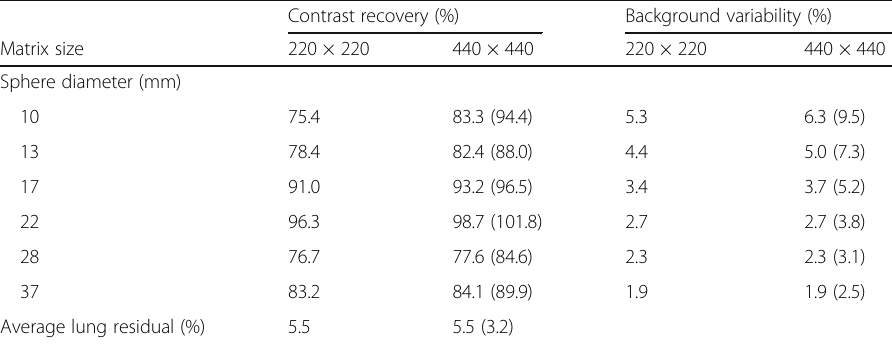
Table 3 Image quality NEMA results for the 4:1 contrast ratio (3D OP-OSEM+PSF + TOF, 4 iterations, 5 subsets, no post-filtering) Contrast recovery (%) Background variability (%) Matrix size 220 × 220 440 × 440